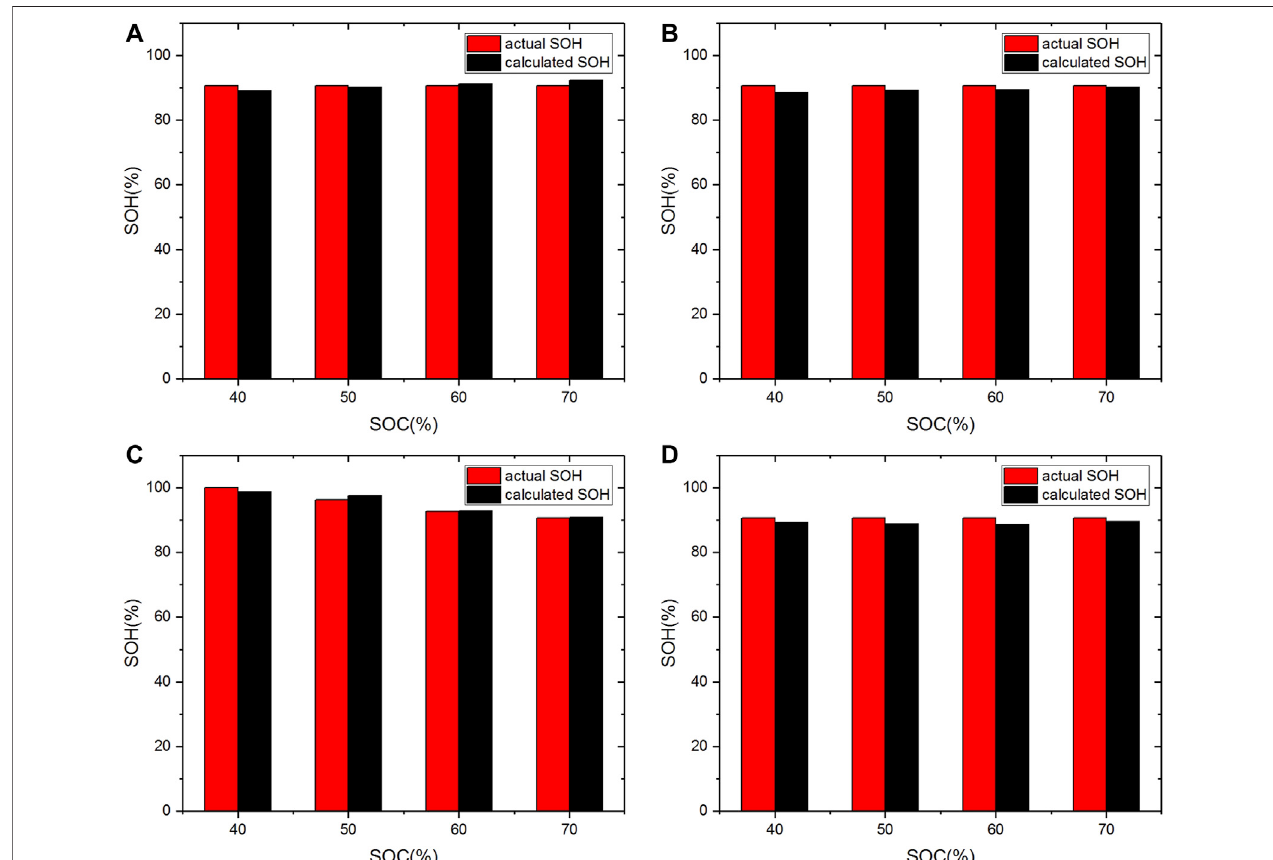
FIGURE 10 | The comparison between the calculated SOH under different SOCs at various temperatures and the actual SOH: (A) 5 ° C, (B) 15 ° C, (C) 25 ° C, and (D) 35 ° C.